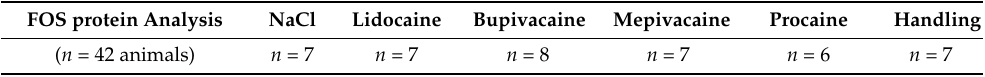
Table 2. Overview: Number of Animals for the FOS Analysis.